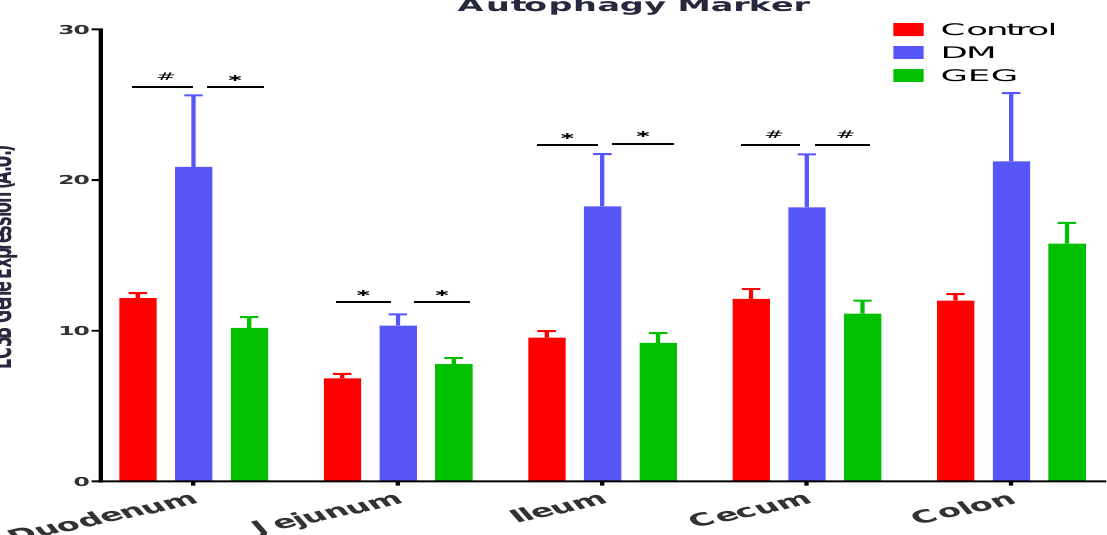
Figure 10. Effect of gingerol-enriched ginger (GEG) on mRNA gene expression of LC3B in duodenum, jejunum, ileum, cecum, and colon of rats. Data is expressed as mean ± SEM. n = 6–8 per group. Data was analyzed by one-way ANOVA followed by a post hoc Tukey’s test. * p < 0.05. # 0.05 < p < 0.1.